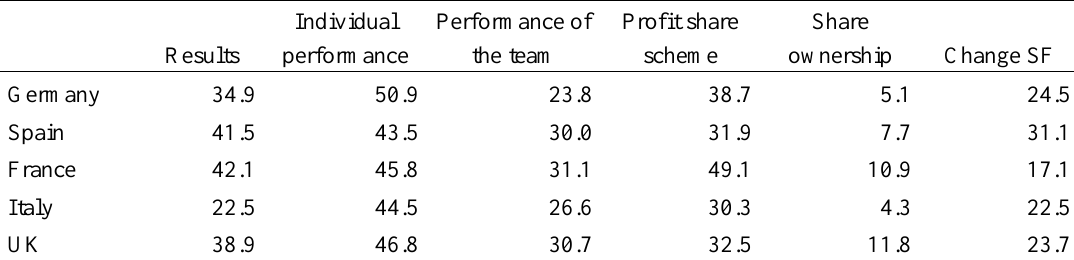
Table 4 . SF by type, country, and change since 2010 (% of establishment) Individual Performance of Profit share Share Results performance the team scheme ownership Change SF 34.9 50.9